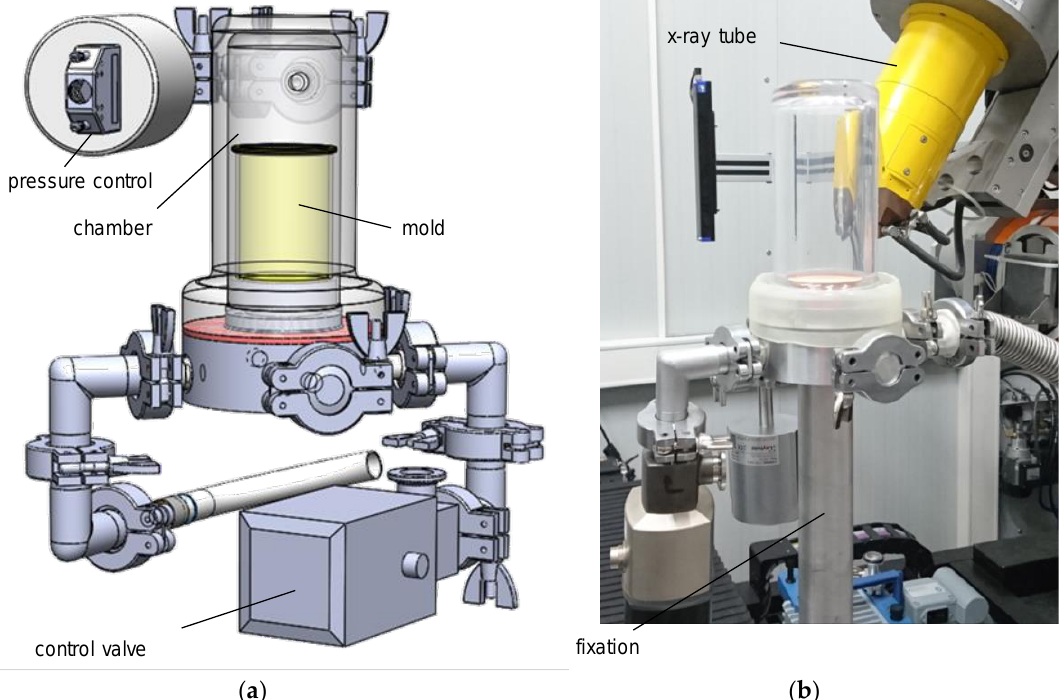
Figure 1. In situ µCT device: CAD model ( a ) and mounting situation ( b ). Figure 1. In situ µ CT device: CAD model ( a ) and mounting situation ( b